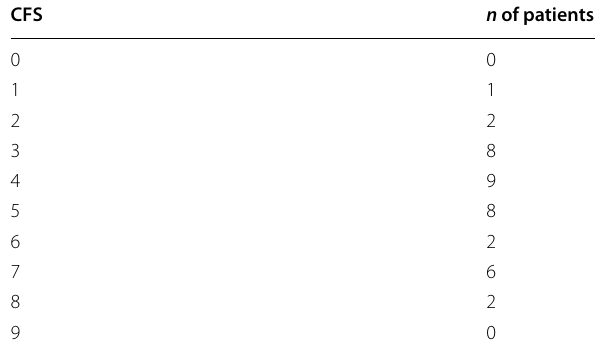
Table 6 Grades of complications according to